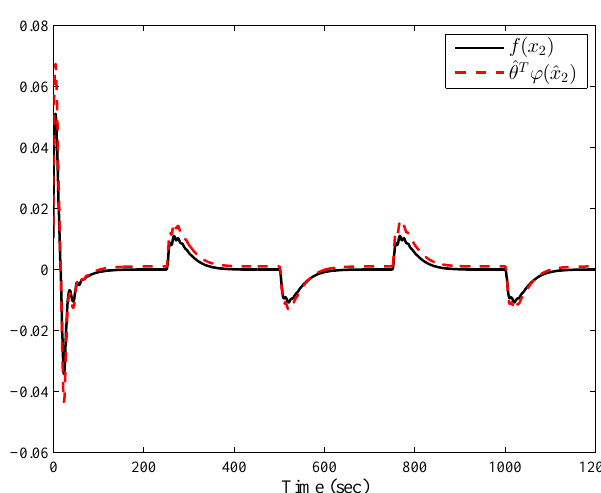
Figure 9. Curves of nonlinear function and its